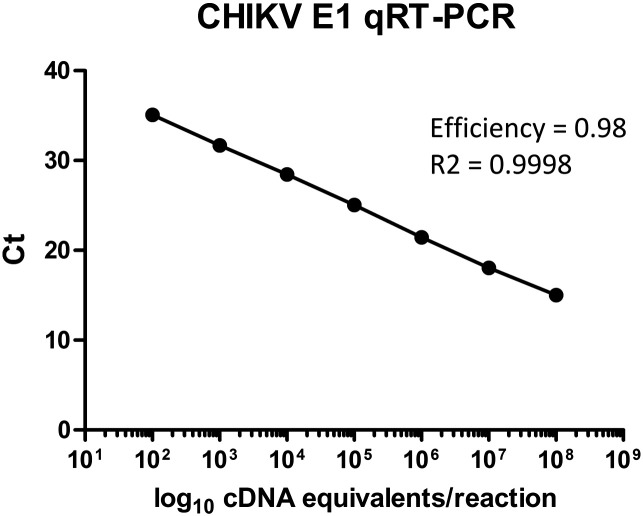
Linear range of the CHIKV E1 RT-PCR assay.